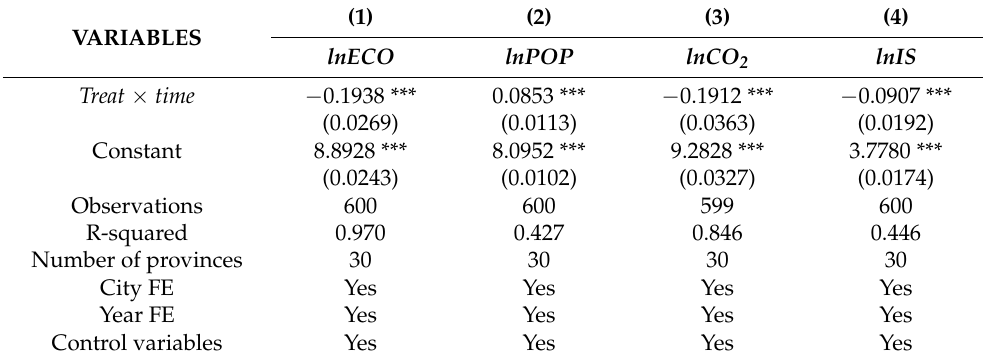
Table 8. Regression results of Mechanism